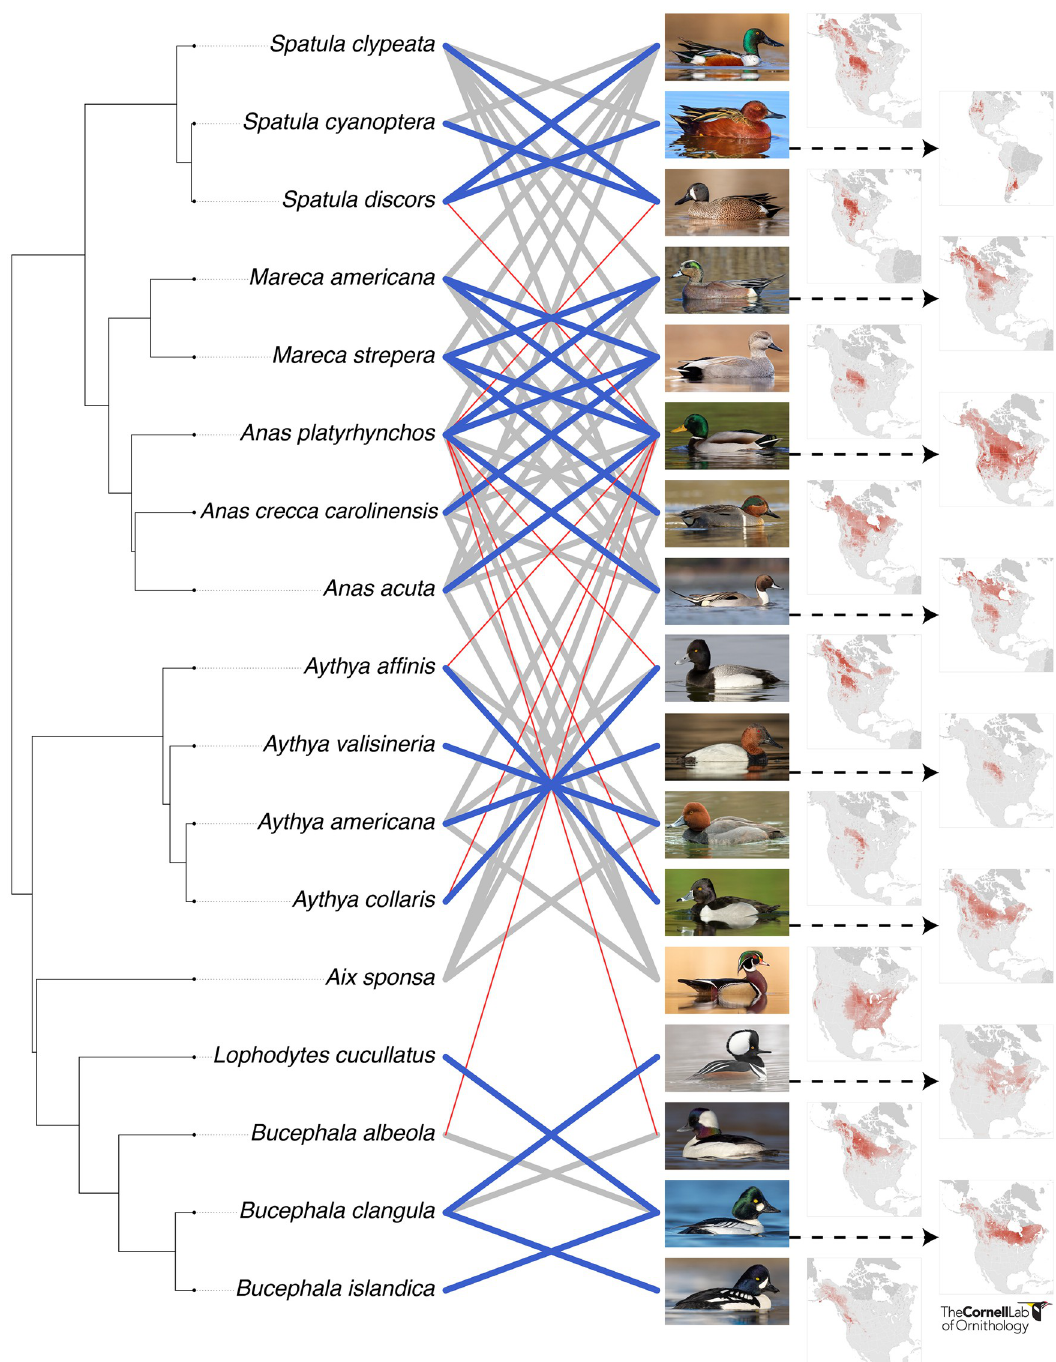
Fig 1. A phylogeny, photographs of males, and breeding season abundance estimates of the study species, where lines between tip labels and photographs convey information about the 127 randomly collected hybrids in our sample ( M . penelope x M . americana excluded). Thick and either thin lines or no lines between tip labels and photographs convey information about the deviation of hybrid frequencies from expectation. Thick lines reprsent hybrids actually received. Thick blue lines represent crosses that occurred more frequently than expected (90% confidence interval) based on geograhic abundance overlaps of parentals; thick grey lines represent crosses received that were within expectations. Thin red lines represent parental combinations for which no hybrids were received, but that were expected to be more common than zero. All hybrid combinations without connecting lines were not received and fell within the 90% confidence intervals of expectations. Image credits from top to bottom: Northern Shoveler,